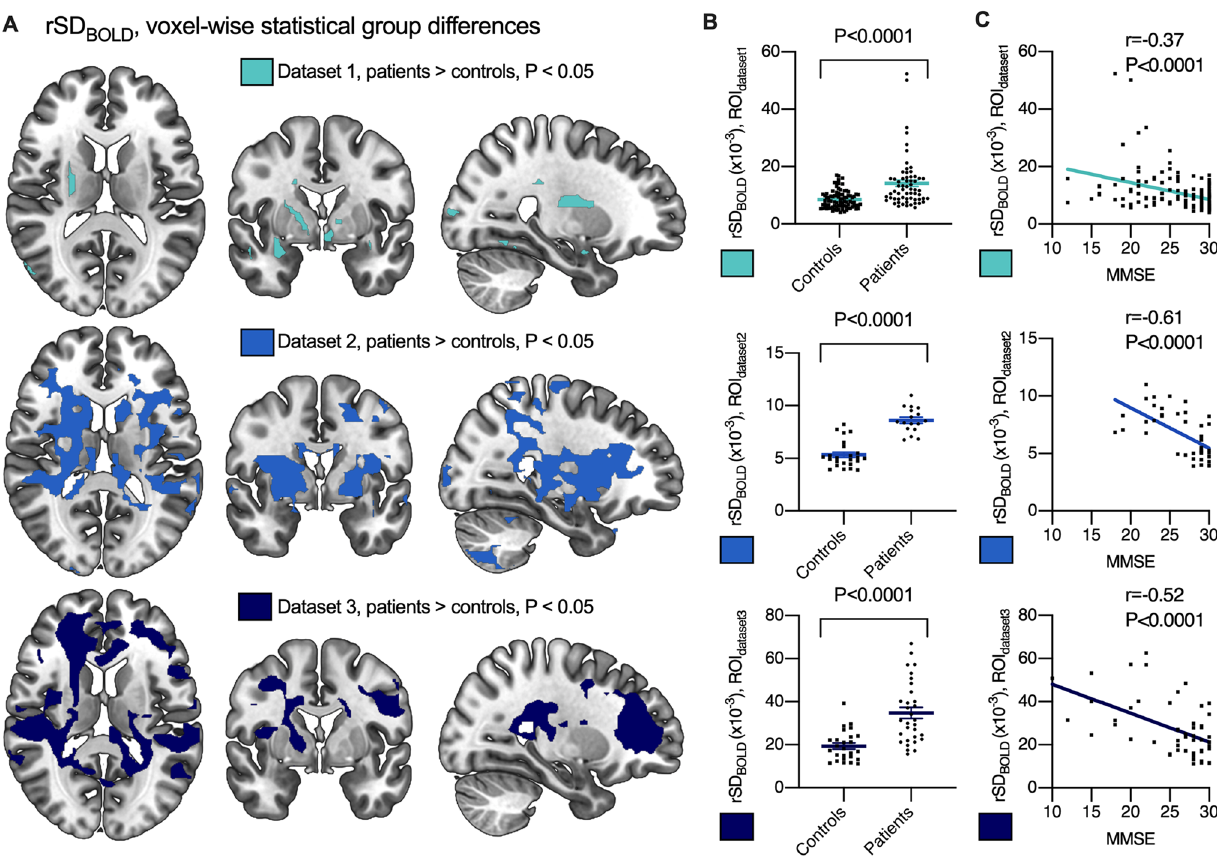
Figure 2. Brain BOLD signal variability in patients with AD compared with controls. Differences in rSD BOLD according to whole-brain voxel-wise analyses ( A ). Maps represent group-level differences where rSD BOLD is higher in Alzheimer’s disease patients (P < 0.05, family wise error corrected). These maps are used as region-of- interests (ROI dataset1 , ROI dataset2 , ROI dataset3 ) in further analysis. ( B ) chart shows the mean ± standard error of the mean rSD BOLD values to group, extracted from each ROI dataset1-3 e.g. significant clusters determined in A . ( C) shows correlation between rSD BOLD and Mini-Mental State Examination